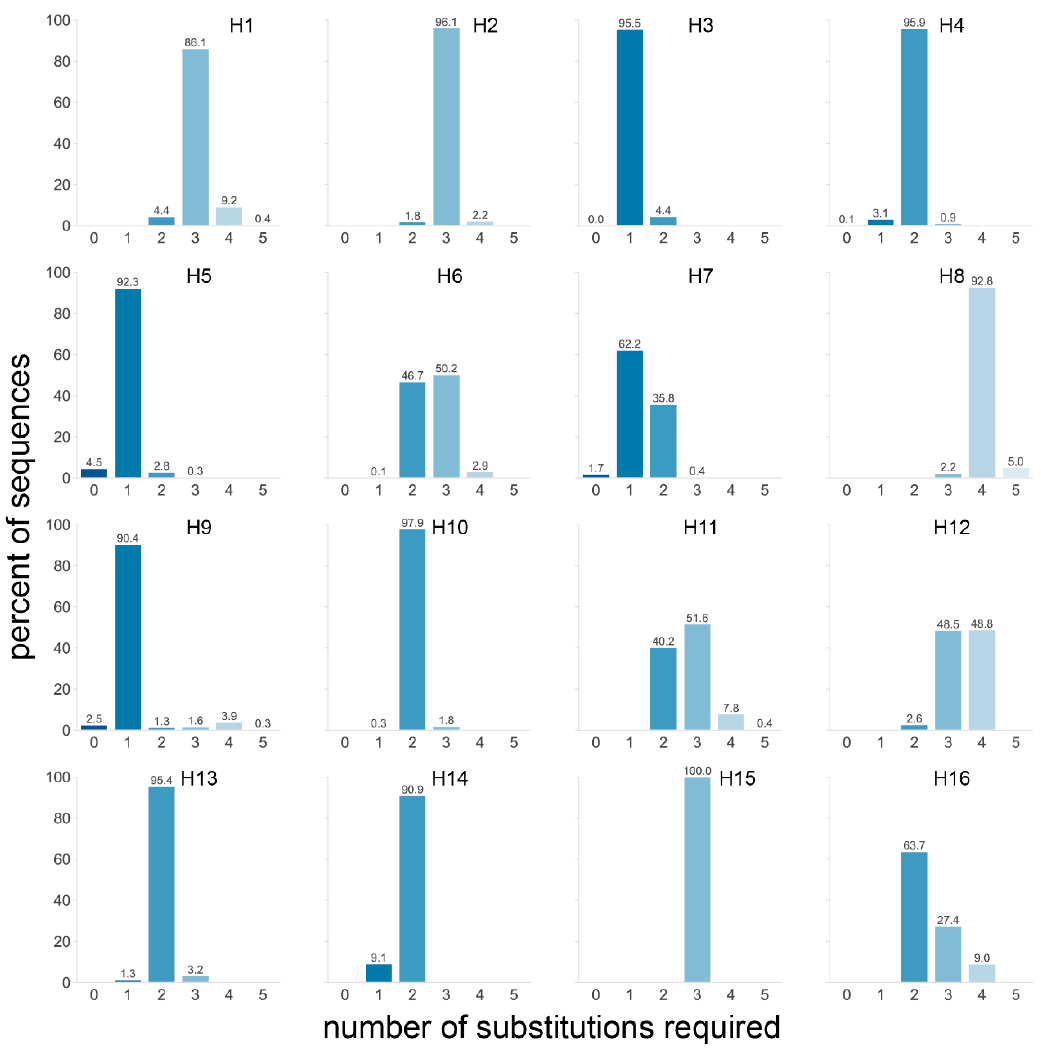
Figure 6. Number of substitutions required in sequences from each subtype to obtain a tribasic cleavage site via substitutions. For each sequence, the number of substitutions required to obtain an arginine in P1 and two other basic amino acids (lysine and arginine only) in P4 to P2 was determined. Only AGG and AGA codons were allowed for arginine, as they represent virtually all arginine codons in HPAIVs in nature. The percentage of sequences requiring a given number of substitutions was calculated independently for each subtype. A darker shade of blue indicates that fewer mutations are required, and the exact percentage is given above each bar.